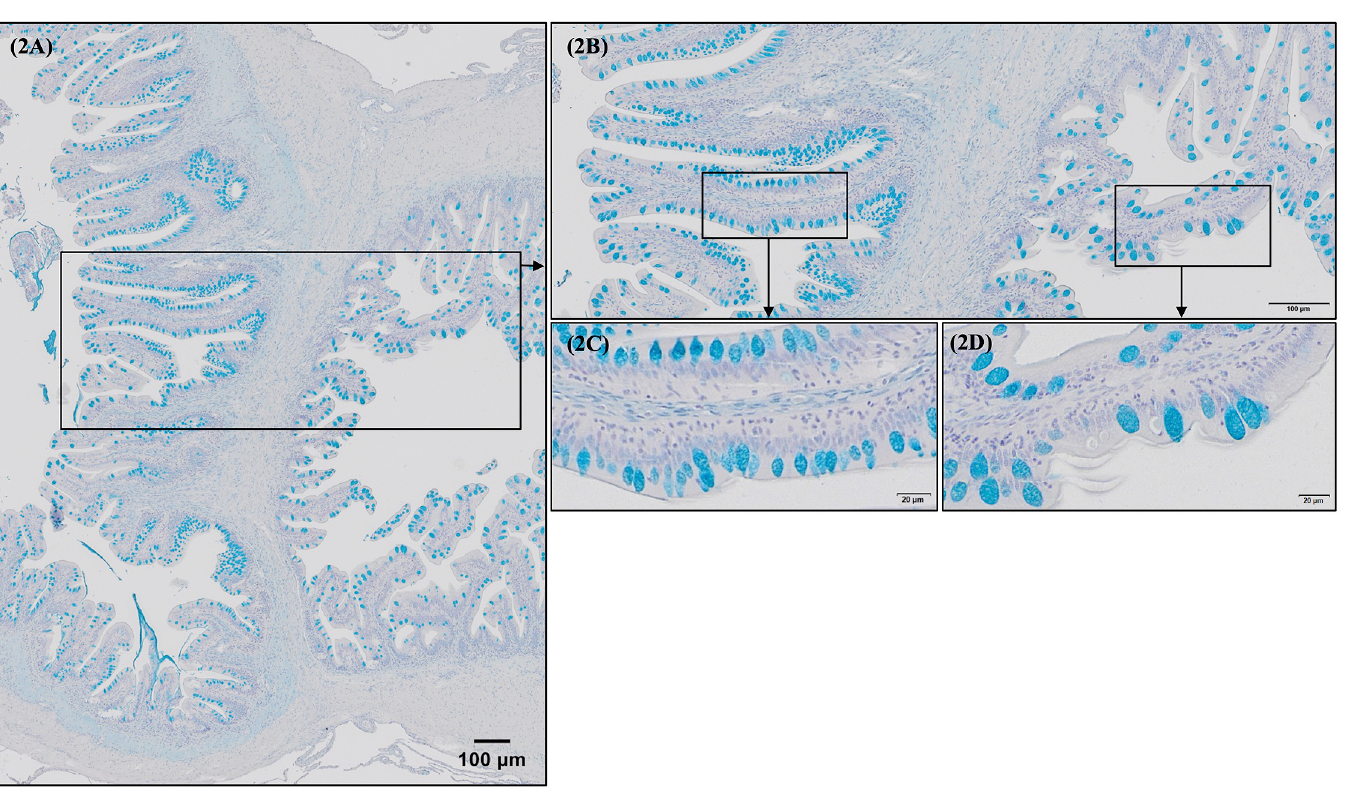
Fig 2. Morphological differences between European sea bass ( Dicentrarchus labrax ) posterior gut (preileorectal valve segment) and rectum (postileorectal valve segments) goblet cell size and distribution on mucosal surface. A similar morphology and mucus production pattern were observed in all the fish intestinal sections studied. A general overview of goblet cell distribution in posterior gut and rectum (separated by ileorectal valve) is detailed in Fig 2A and 2B (Alcian Blue, pH = 2.5; Bar 100 μ m). Note the greater fold area covered by mucus in posterior gut compared to rectum as a result of increased cell density as posterior gut goblet cells are smaller than goblet cells located in rectum (Fig 2C vs 2D; Alcian Blue, pH = 2.5; Bar 20 μ